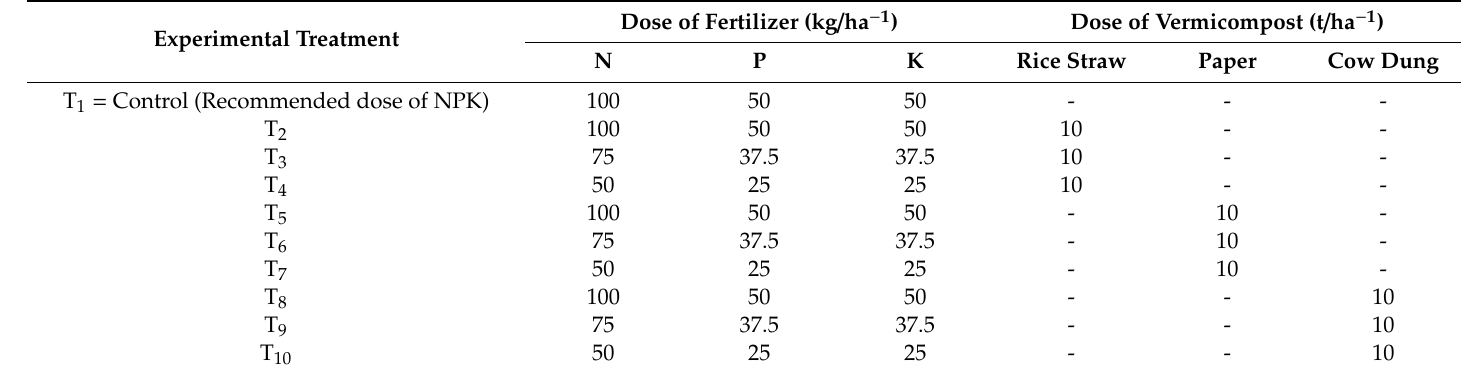
Table 2. Experimental treatments of the